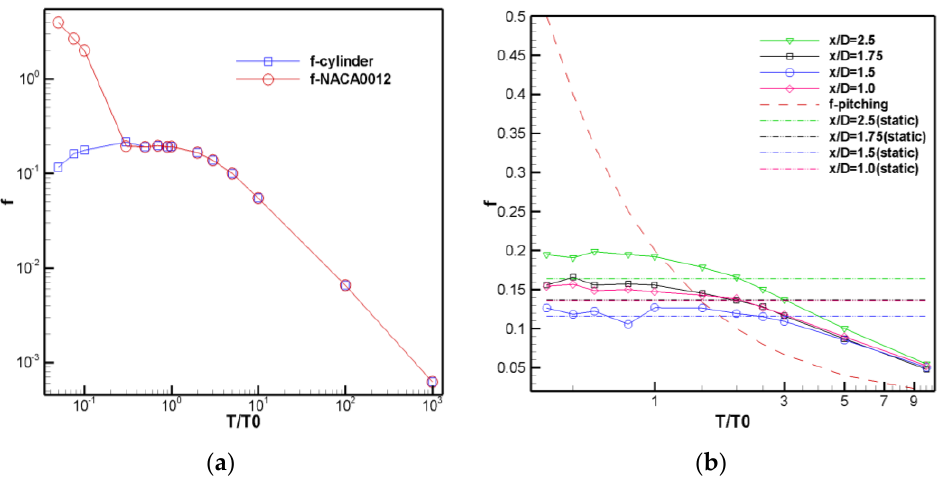
Figure 6. The frequency of lift coefficient varying with T / T 0 : ( a ) The frequency of airfoil and cylinder ( x / D = 2.5); ( b ) Coupled frequency. ( x / D = 2.5); ( b ) Coupled